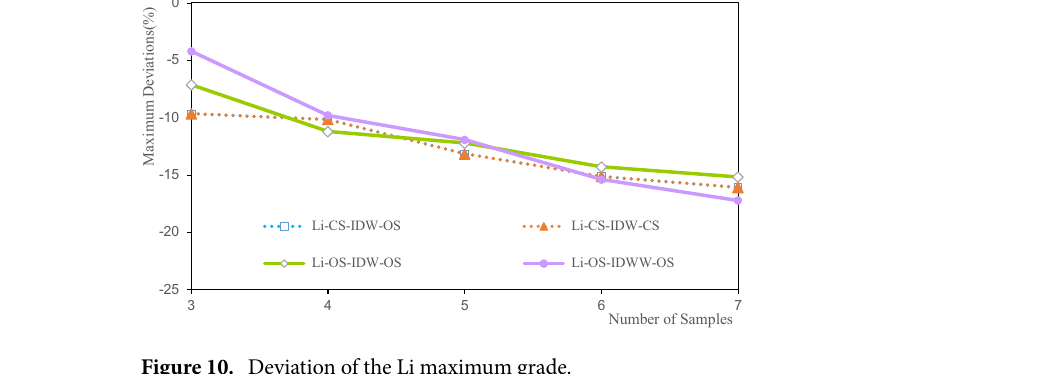
Figure 10. Deviation of the Li maximum grade.